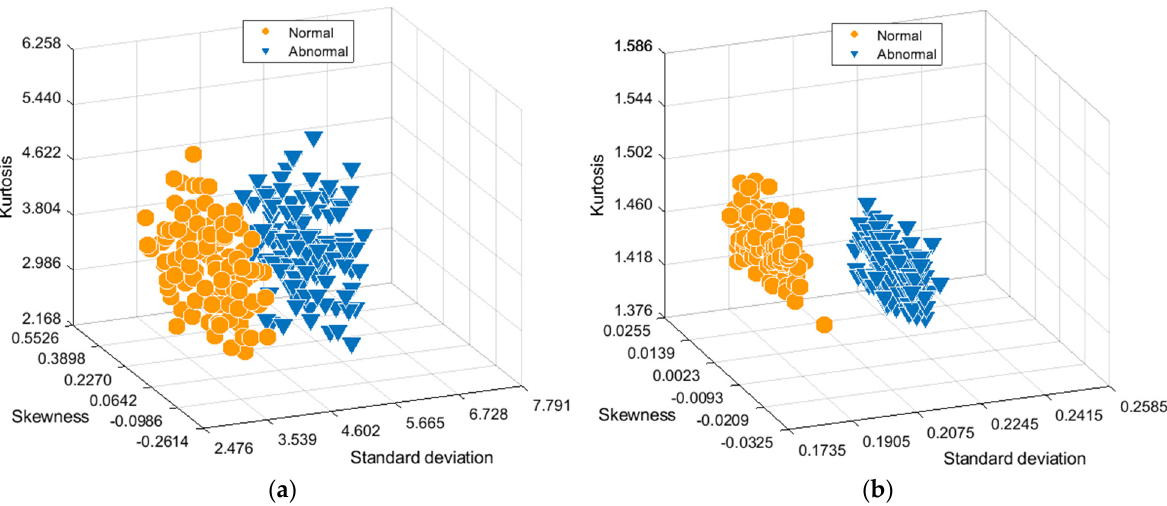
Figure 9. The distribution scatters diagram of the three-time domain features in working condition 5 under displacement interval 420 mm: ( a ) Feature distribution of vibration signals; ( b ) Feature distribution of the current signals.